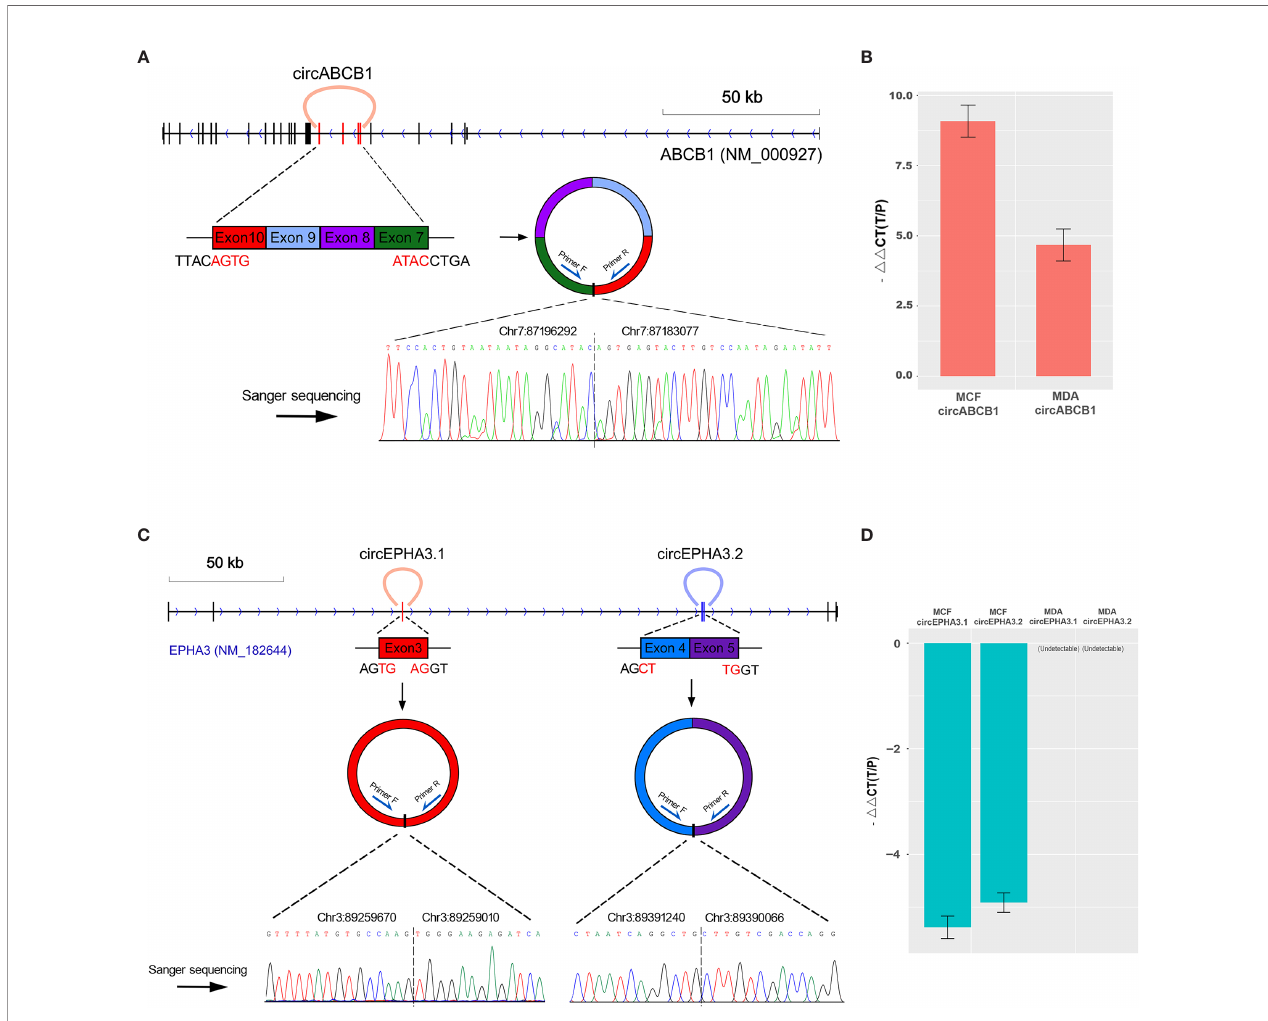
FIGURE 3 | Structure analysis and qPCR validation of circRNAs. (A) The upper panel shows the cyclized exons and the structure of circABCB1 in the ABCB1 gene locus. The bottom panel shows Sanger sequencing of the PCR product of the junction sequence. (B) qPCR validation of circABCB1 expression in MCF-7 and MDA cells, with GAPDH used as an endogenous control. The heights of the red columns represent the logarithmically transformed mean fold-changes between the resistant and parental cells detected by qPCR. Data from triplicate measurements are presented as mean ± standard error. (C) The upper panel shows the cyclized exons and structures of circEPHA3.1 and circEPHA3.2 in the EPHA3 gene locus. The bottom panel shows Sanger sequencing of the PCR product of the junction sequence. (D) qPCR validation of circEPHA3.1 and circEPHA3.2 expression in MCF-7 and MDA cells, with GAPDH used as an endogenous control. The heights of the blue columns represent the logarithmically transformed mean fold-changes between the resistant and parental cells detected by qPCR. Data from triplicate measurements are presented as mean ± standard